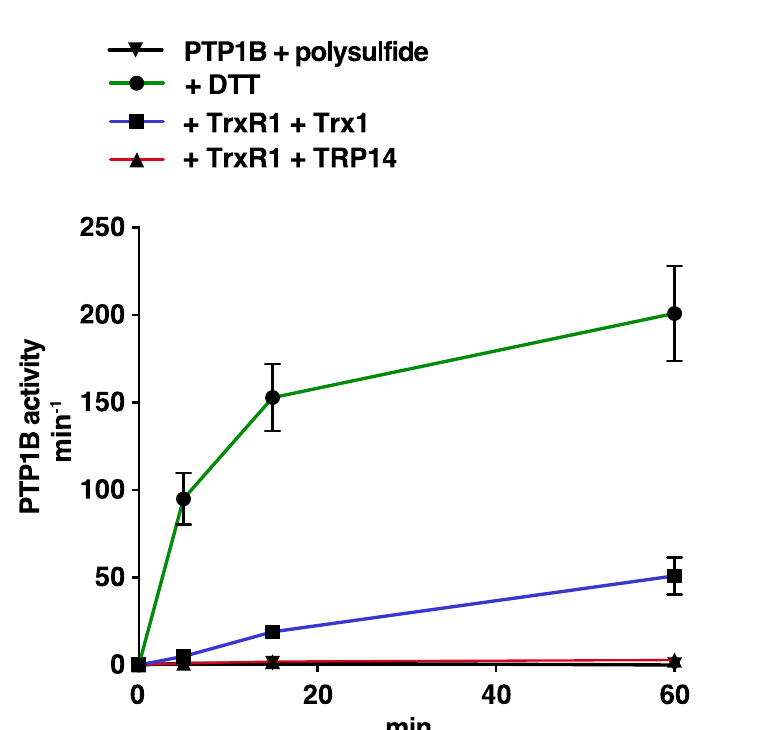
Figure 4. Reactivation of polysulfide-inactivated PTP1B by the Trx1 or TRP14 systems. Recombinant PTP1B was completely inactivated using incubation with 100 µ M polysulfide. After desalting, the oxidatively inactivated PTP1B was then incubated with 2 mM DTT (green) or 10 µ M of either Trx1 (blue) or TRP14 (red) together with TrxR1 (2.5 µ M) and NADPH (300 µ M), as indicated. Reactivated PTP1B activity was then determined after incubations of 5, 15, and 60